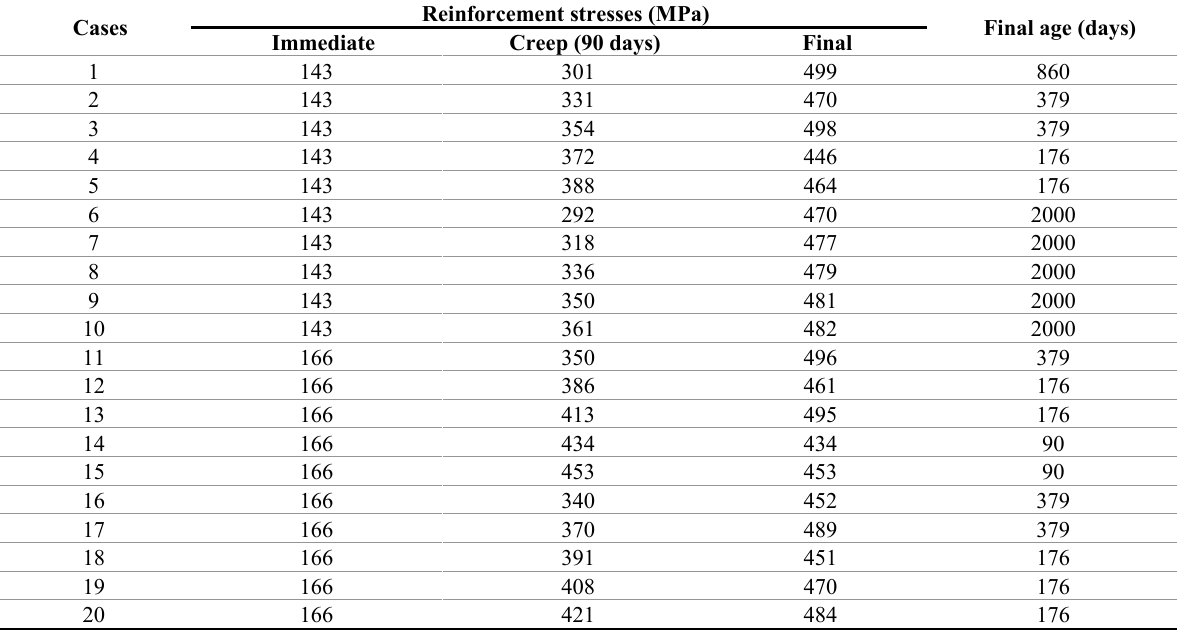
Table 4. Stresses on the